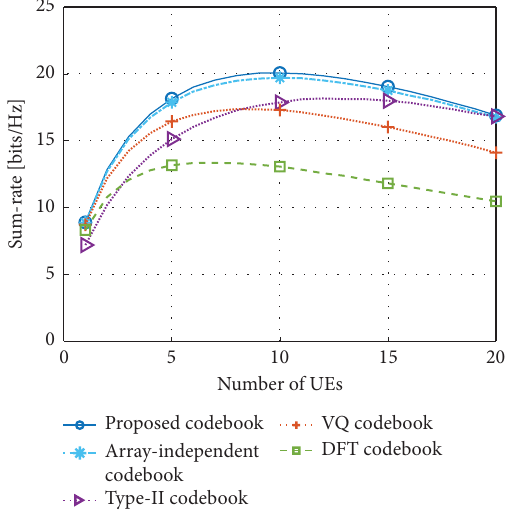
Figure 13: MU-MIMO sum-rate performance comparison of the proposed and exiting codebooks for diferent numbers of users involved in simultaneous